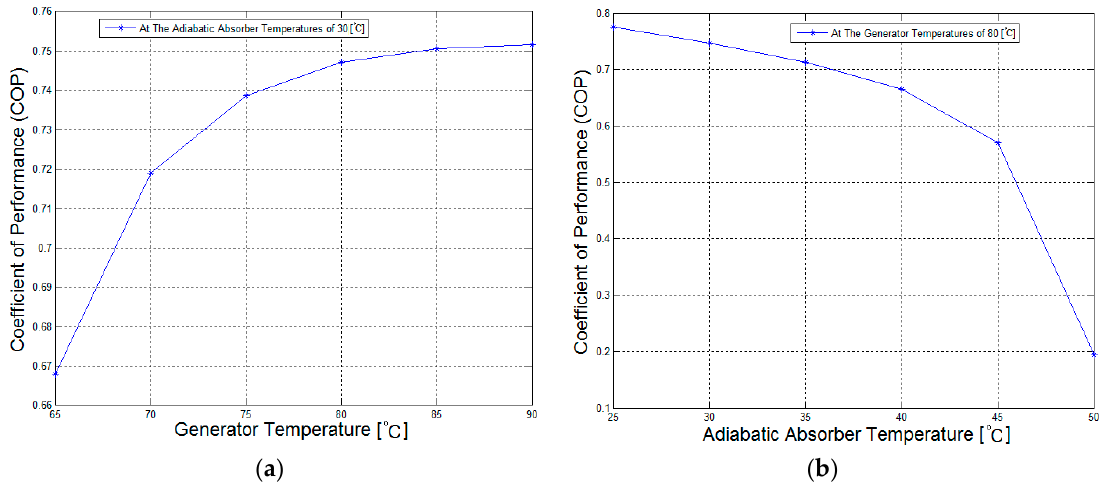
Figure 9. The influences of: ( a ) the generator temperature on the absorption refrigeration system performance ( T con = 35 ◦ C, T eva = 10 ◦ C, T abs = 30 ◦ C ) ; and ( b ) the adiabatic absorber temperature on the absorption refrigeration system performance ( T con = 35 ◦ C, T eva = 10 ◦ C, T gen = 80 ◦ C )